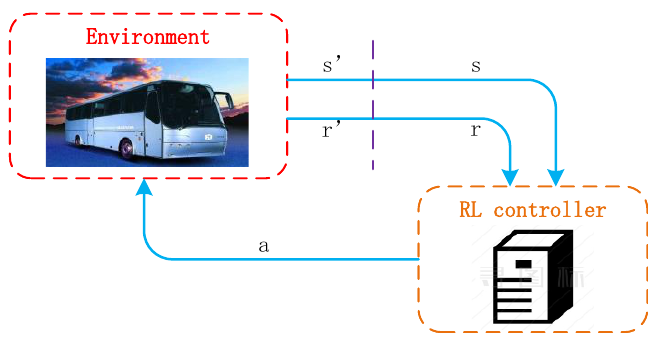
Figure 4. Basic process of agent–environment interaction for deep reinforcement